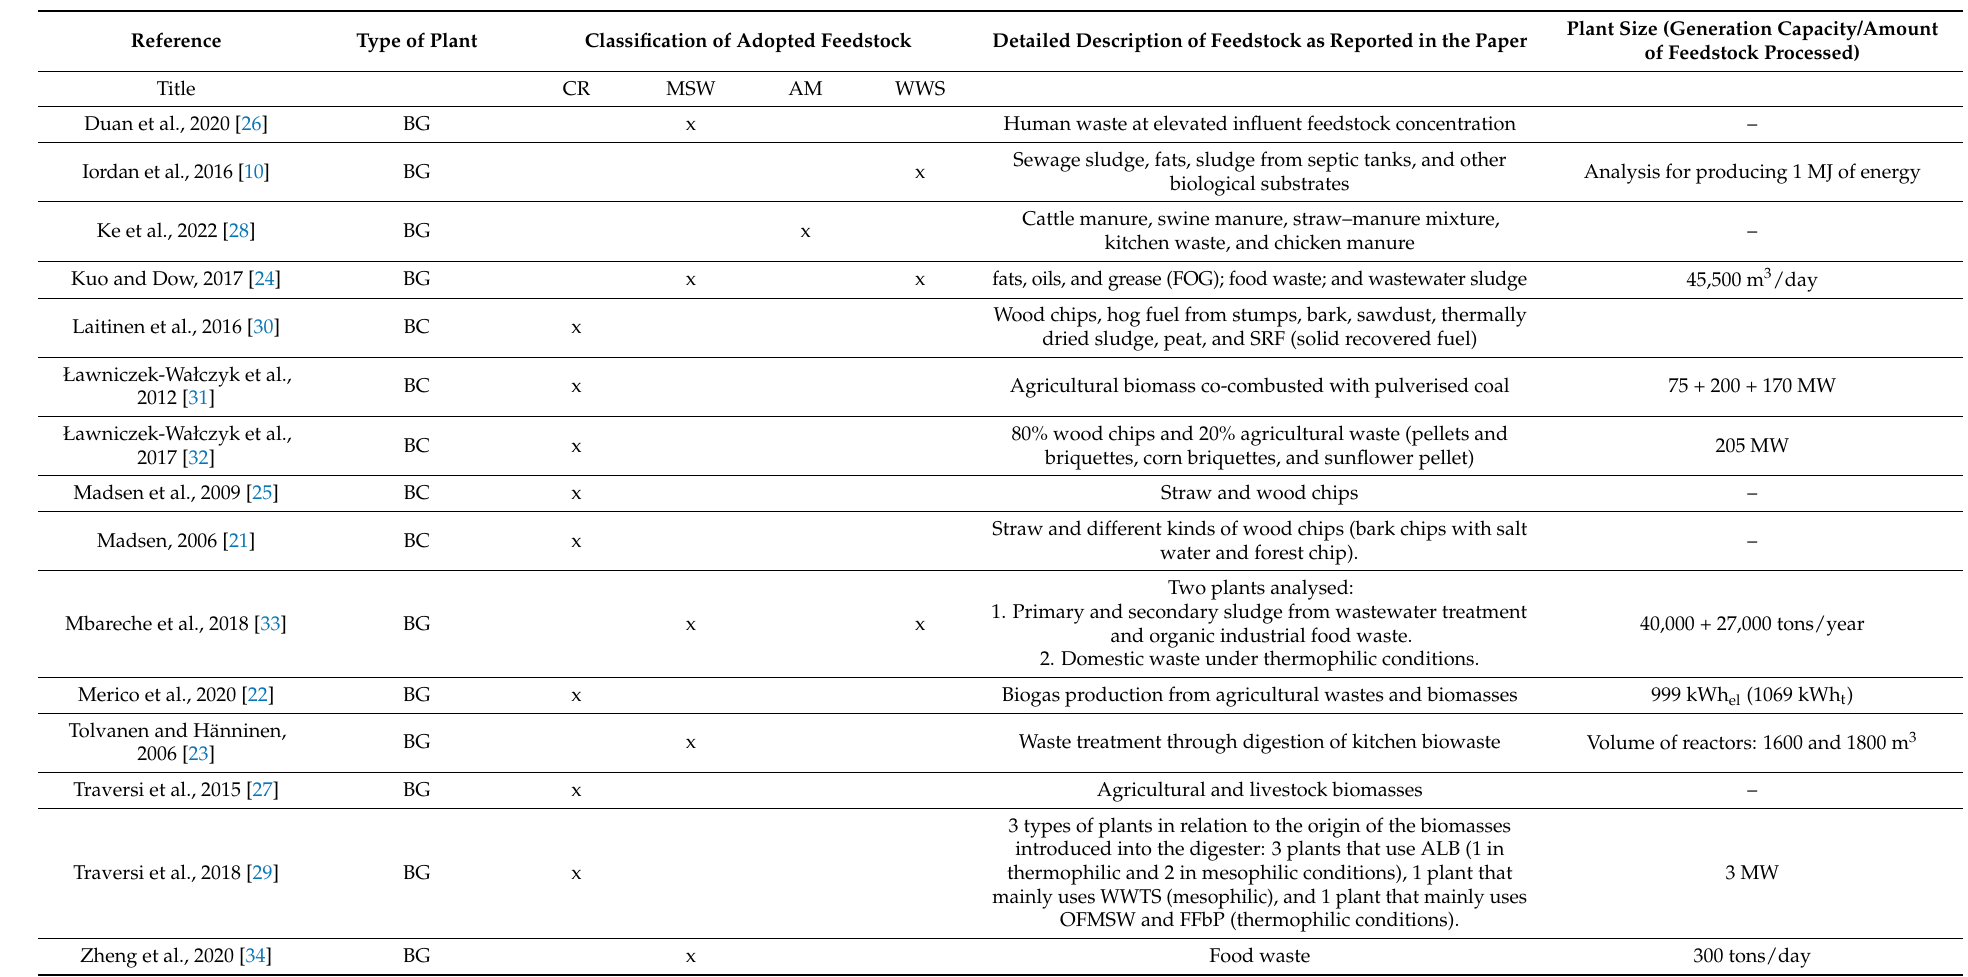
Table 5. Overview of the plants analysed in the included studies (BG= biogas plants implementing anaerobic digestion, and BC= power generation through biogas